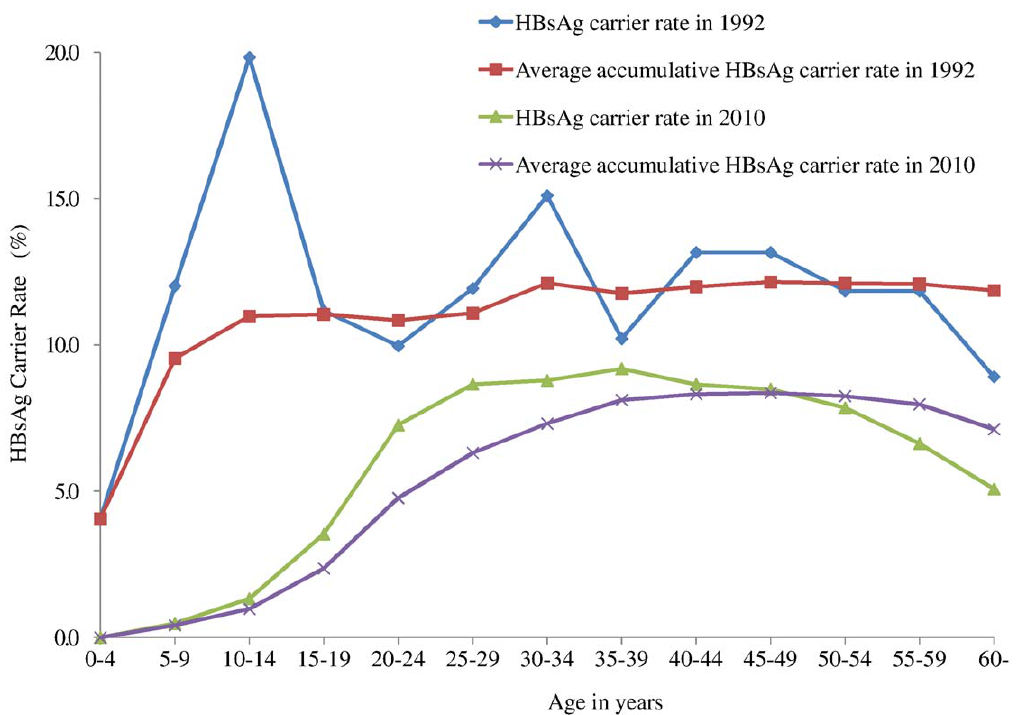
Figure 2. Comparison of HBsAg carrier rate and average cumulative HBsAg carrier rate by age (0 to 60 years) between 1992 and 2010. The blue line represents the carrier rate in different age groups in 1992, the red line the average cumulative carrier rate from zero to a specific age group in 1992, the green line the carrier rate in different age groups in 2010, and the purple line the average cumulative carrier rate from zero to a specific age group in 1992.